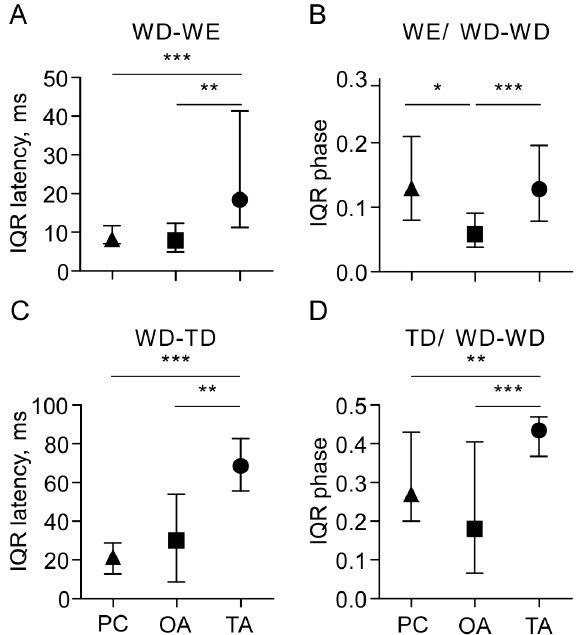
Figure 8. Phase histograms giving the timing of different motor units (TL, TD, WE) within the cycle length for a representative recording of the flight rhythm (WD-WD cycle, normalized) as evoked by A pilocarpine (1 mM), B octopamine (100 mM), C tyramine (100 mM) and D wind: TL (upper trace in each panel), TD (second trace) and WE (third trace) in a normalized WD-WD cycle. Each bin gives the number of spikes occurring in 1/50th of the cycle